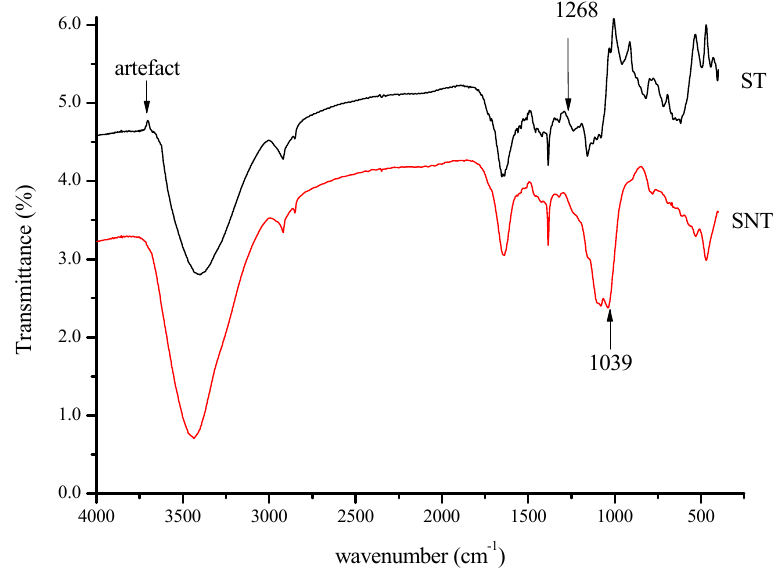
Figure 1. FT-IR in 4000–400 cm − 1 spectra region of rice straw. SNT (straw not treated) indicates the spectra of rice straw untreated (natural), and ST (treated straw) indicates the spectra of rice straw treated with NaOH.